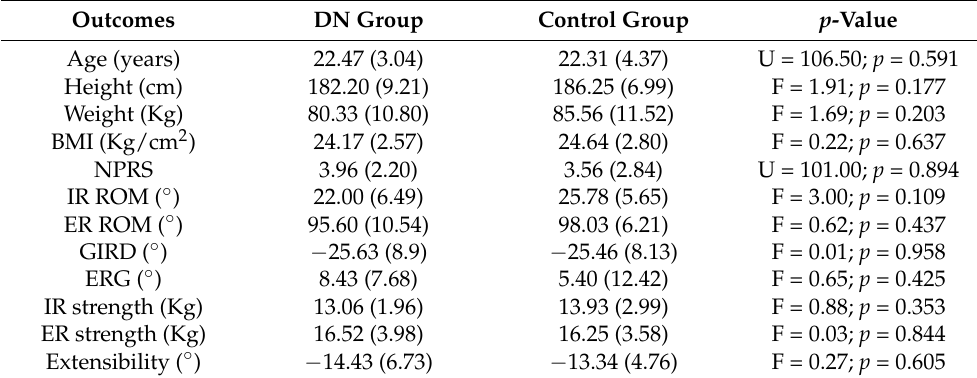
Table 1. Sociodemographic and clinical